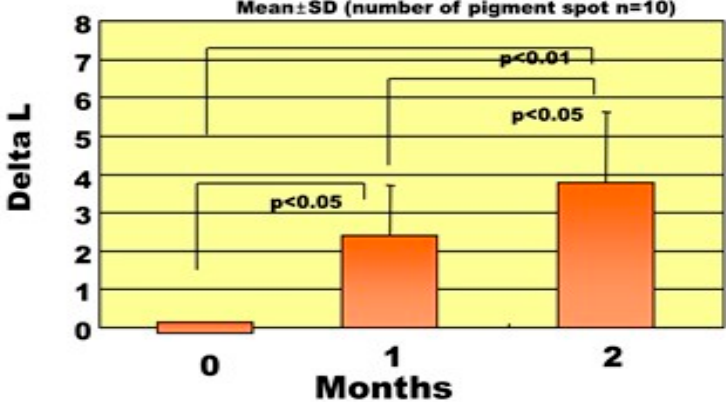
Figure 7. Changes in the Δ L values of SLs after treatment for two months [1].